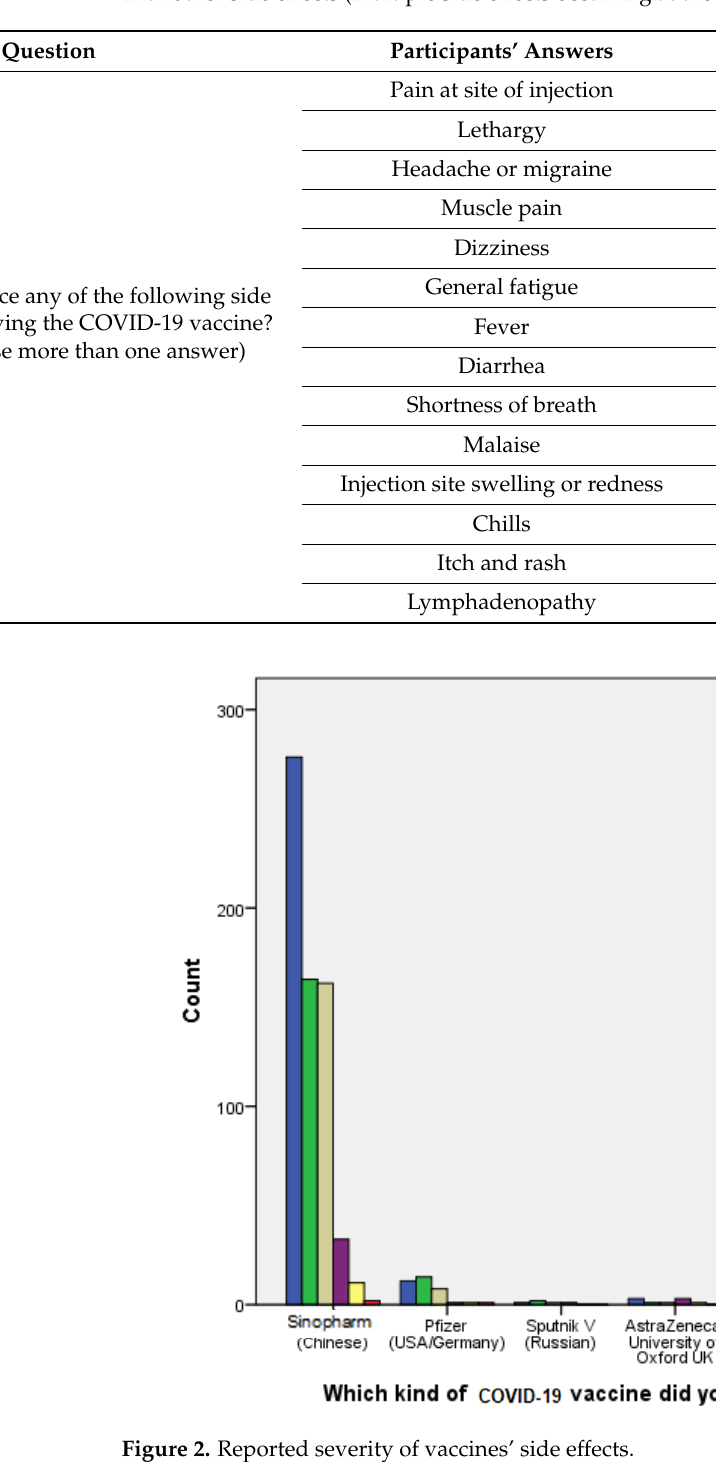
Table 5. Number and percentages of vaccination adverse events that are reported in combination with other side effects (multiple side effects occurring at the same time).